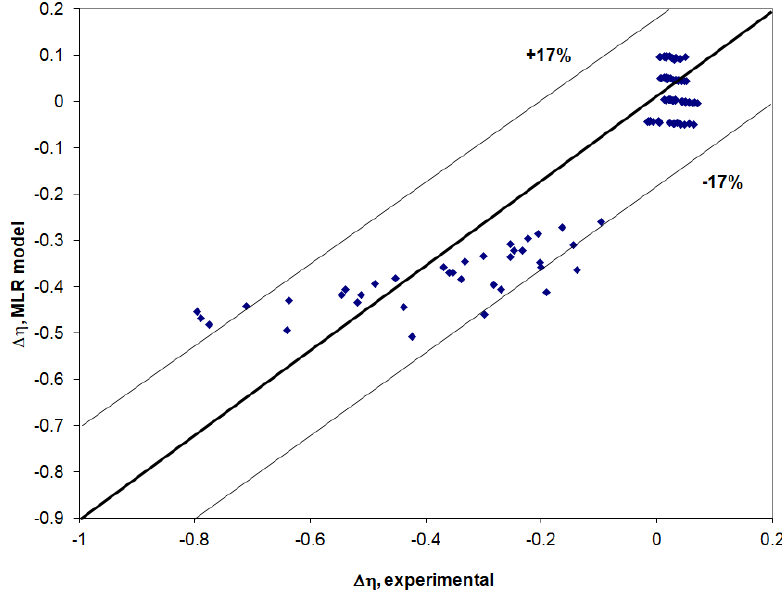
Figure 5. Viscosity deviation calculated with the (MLR) proposed model (Equation (9)) compared to experimental values.